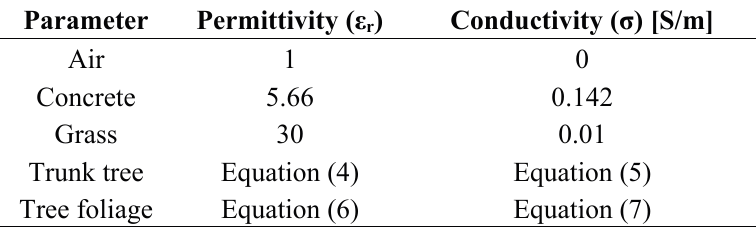
Table 1. Material properties in the ray launching